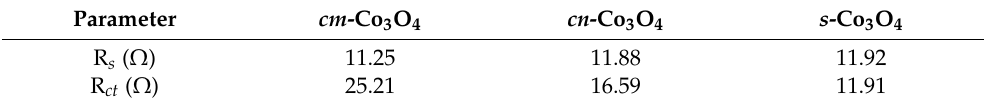
Table 1. The extracted physical parameters of each catalyst from the Nyquist plots in Figure